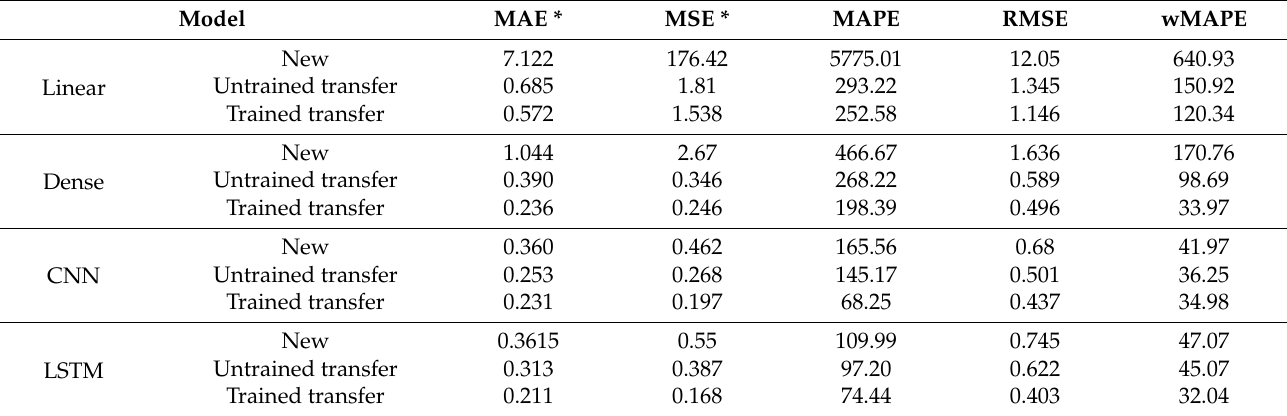
Table 4. The performance of presented models on db 2 by considering different evaluation